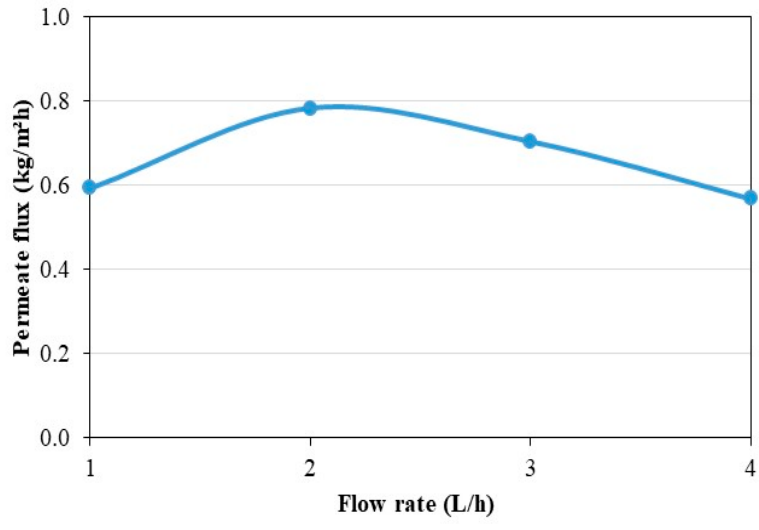
Figure 10. Effect of flow rate on permeate flux in continuous mode.